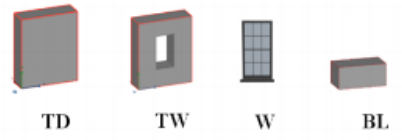
Figure 6. Basic shape vocabulary elements { 𝑆 } for parametric shape grammar